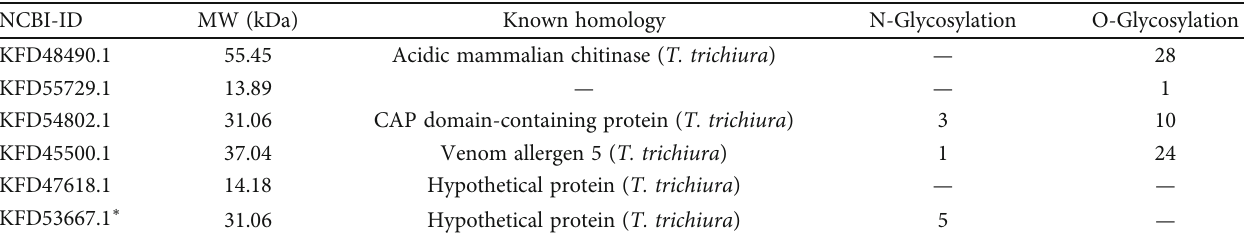
Sequence similarity search for protein homology was performed using BLAST/NCBI. Glycosylation prediction was performed using NetOGlyc 4.0.0.13 for O- glycosylation and NetNGlyc 1.0 Server for N-glycosylation. ∗ Formerly identi fi ed using HelmDB database and recombinantly expressed based on